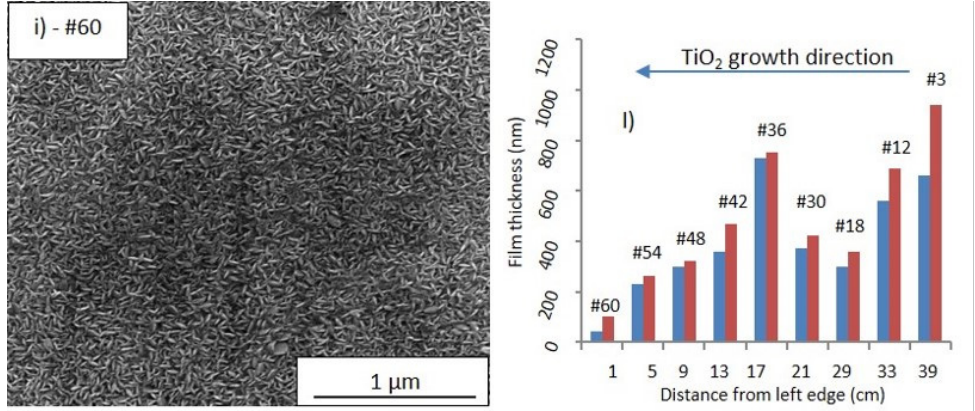
Figure 4. SEM images (100,000× magnification) of the TiO 2 -SSM portions #3 ( a ), #12 ( b ), #18 ( c ), #30 ( d ), #36 ( e ), #42 ( f ), #48 ( g ), #54 ( h ), and #60 ( i ). TiO 2 film thickness (blue = minimum value, red = maximum value within the analysed portion) as a function of the position (distance from left edge, i.e., left side of the sample) for the correspondent portions ( l ).